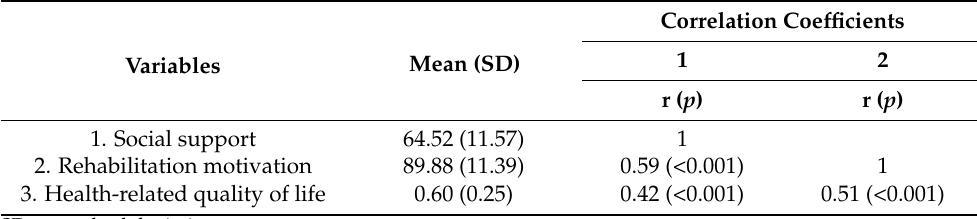
Table 2. Correlations between social support, rehabilitation motivation, and health-related quality of life ( n = 176).